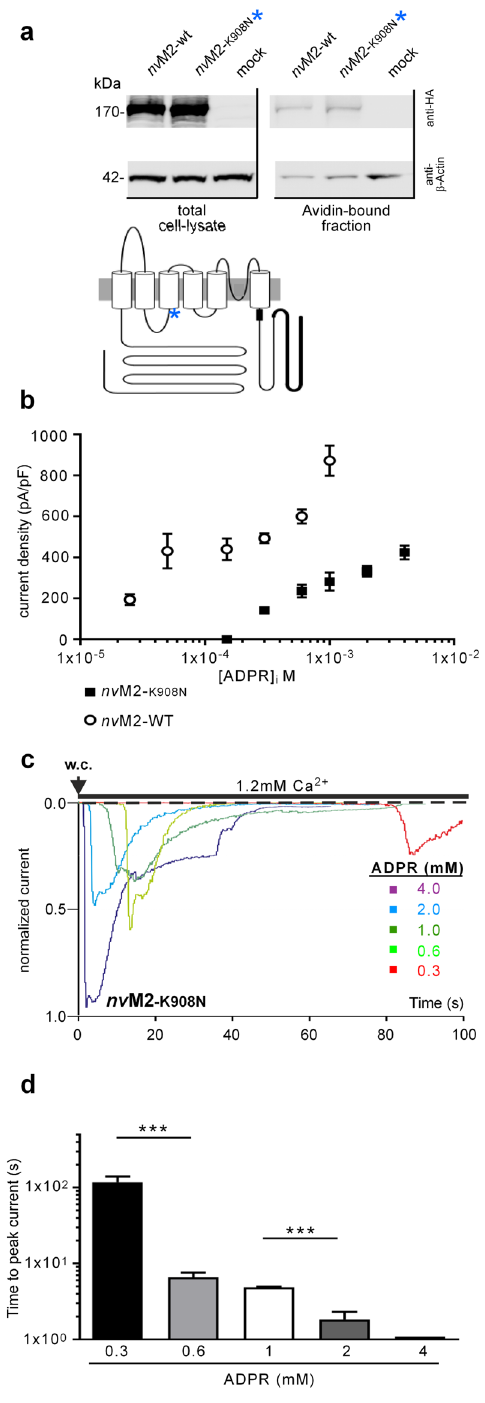
Figure 6. Diminished effects of ADPR in the K908N variant of nv TRPM2. ( a ) Upper . Cell surface expression, assessed with biotinylation assays, of wild-type nv TRPM2 and the variant K908N (as indicated), each containing a C-terminally attached 3xHA tag (only for Western blot analysis). Western blots on the NeutrAvidin-bound fractions ( right ) and on total HEK-293 cell lysates ( left ) were probed with anti-HA antibody. Full-length blots are presented in Supplementary Figure S2. Lower . Sketch indicating the approximate location of the point mutation K908N within the nv TRPM2 structure. ( b ) On nv TRPM2-K908N, ADPR acts with diminished potency and efficacy. Plotted are peak current densities (mean ± S.E.M; n = 4–9) of wild- type and mutant, in response to various concentrations of ADPR in the pipette solution (as indicated). ( c ) Current amplitude as well as lag time of current development depend on the ADPR concentrations, as shown in representative traces with various concentrations of ADPR in the pipette solution (as indicated). ( d ) Summary of experiments as derived from panel c. Note the logarithmic ordinate. Significant differences are indicated with asterisks ( *** P < 0.001; Student’s t-test, n = 5–7). Error bars are